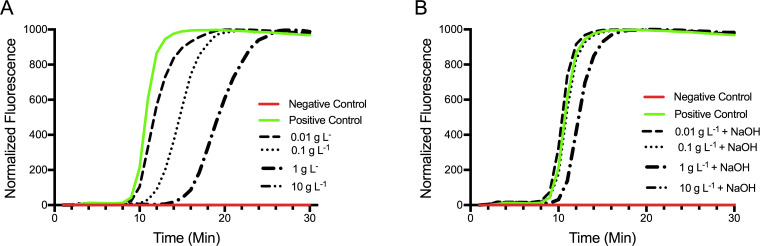
Increasing sample pH to prevent LAMP inhibition by chitosan.Representative LAMP amplification curves for samples (pH 5.8 and pH 11) containing 0.0, 0.01, 0.1 and 1 g L-1 chitosan. Samples (pH 5.8) containing 10 g L-1 chitosan completely inhibited LAMP. Samples containing 1 g L-1 chitosan significantly inhibited LAMP amplification while samples containing 0.01 and 0.1 g L-1 only slightly inhibited LAMP when compared to the positive control not containing any chitosan (A). The addition of NaOH to samples removed most of the inhibition on LAMP (B). All reactions contained 0.2 ng E. coli 25922 DNA except the negative control. 3 replicate assays were performed for each condition. One representative curve from each treatment condition is shown.